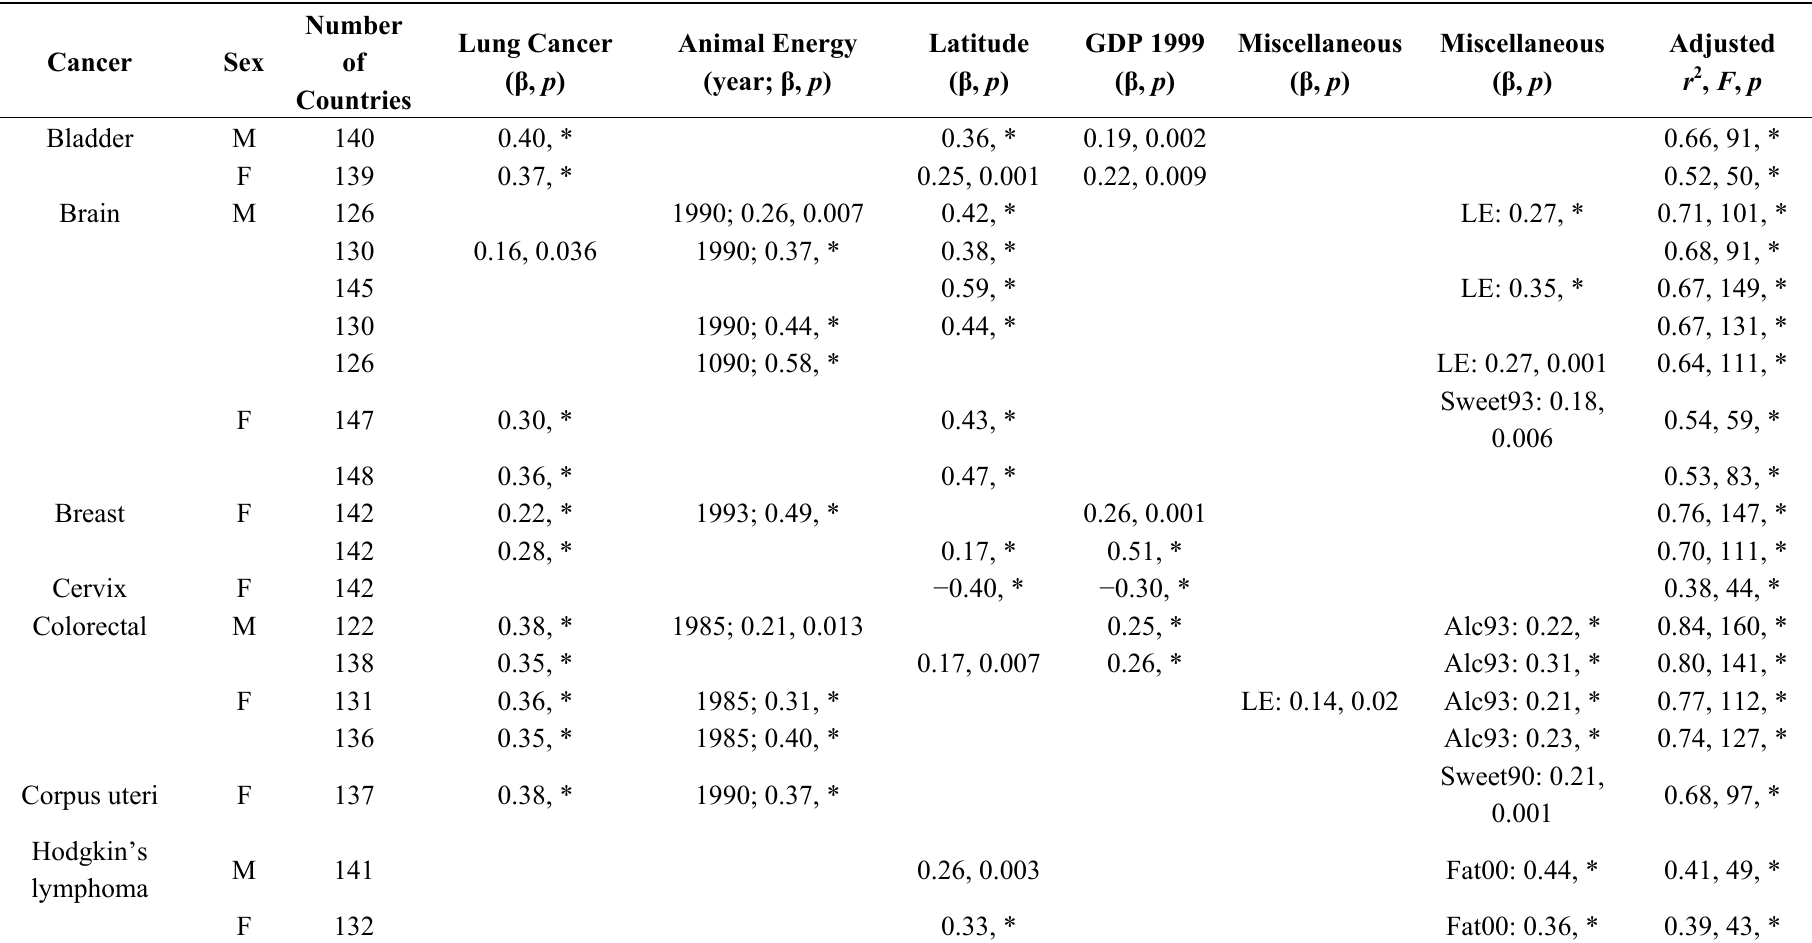
Table 3. Regression results for the 157